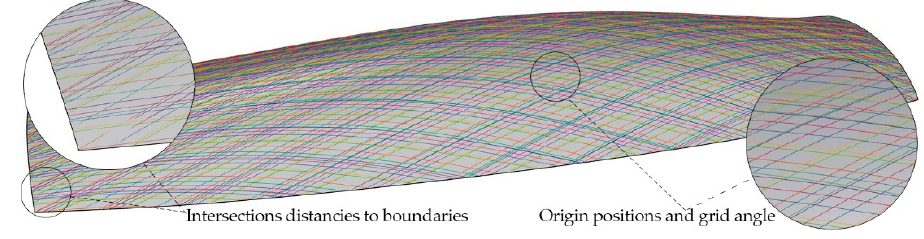
Figure 23. Superimposed selected solutions.